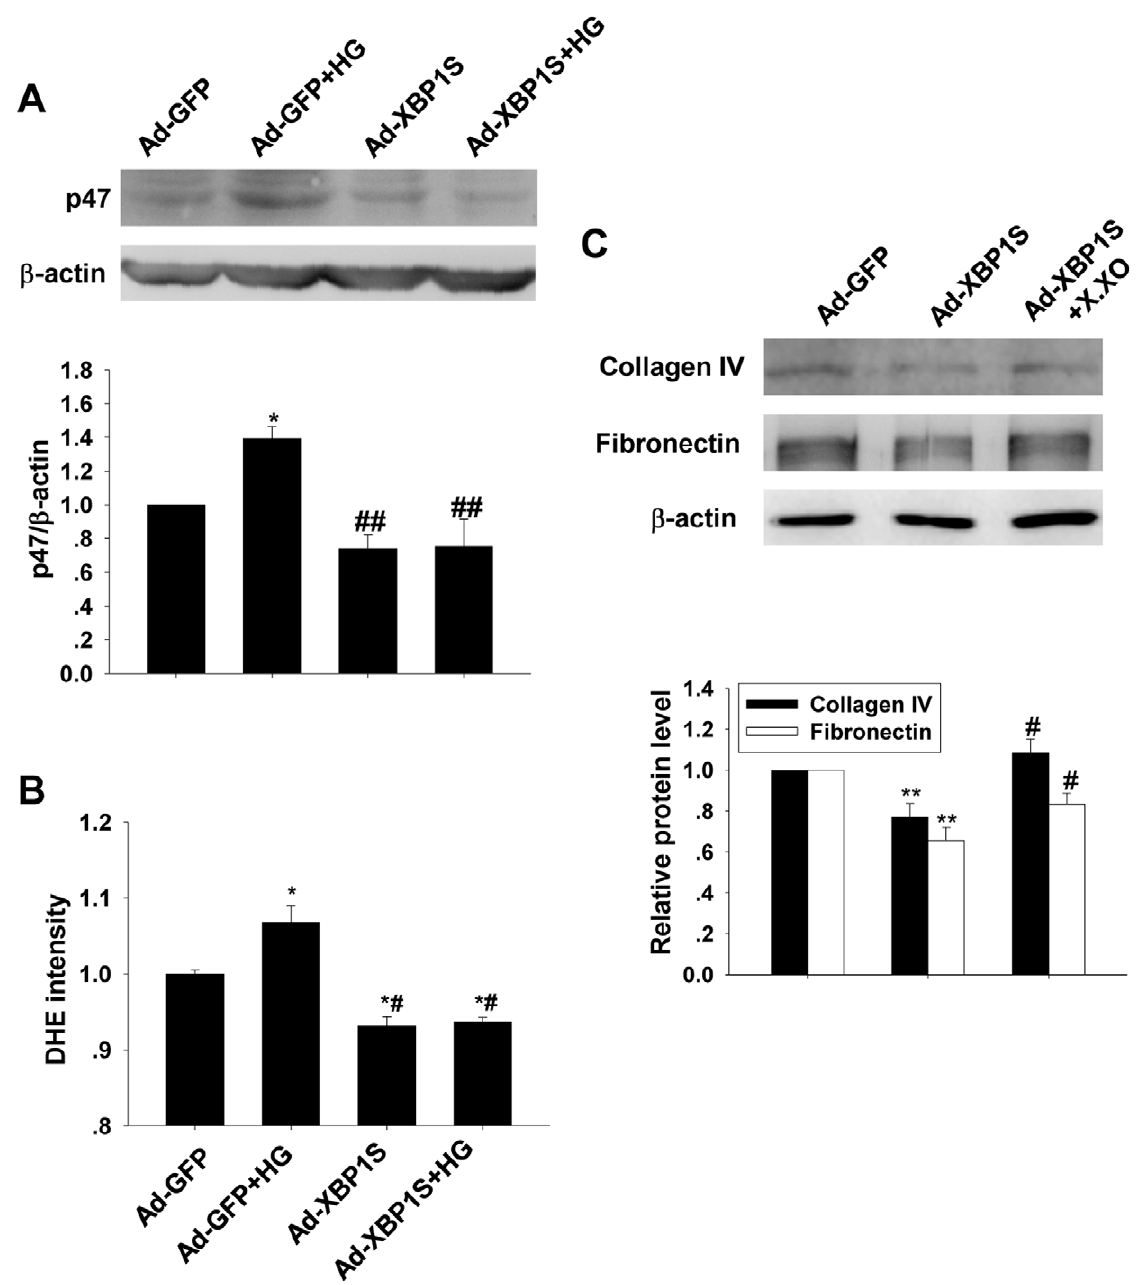
Figure 6. Changes in p47 and ROS generation after transfection of Ad-GFP or Ad-XBP1S. A: Western blot analysis on p47phox levels in the cultured MCs before and after Ad-XBP1S transfection for 48 h (mean 6 SEM, n=5). B: Observation of ROS generation by DHE fluorescent probe assay in the cultured MCs before and after Ad-XBP1S transfection for 48 h (mean 6 SEM, n=8). * p , 0.05 compared to NG; # p , 0.05 compared with HG; ## p , 0.01 compared to HG. C: Western blot analysis on collagen IV and fibronectin levels after transfection of Ad-XBP1S or Ad-XBP1S + xanthine and xanthine oxidase (X ? XO) for 48 h in the presence of HG. ** p , 0.01 compared to Ad-GFP; # p , 0.05 compared with Ad-XBP1S (mean 6 SEM, n=5).